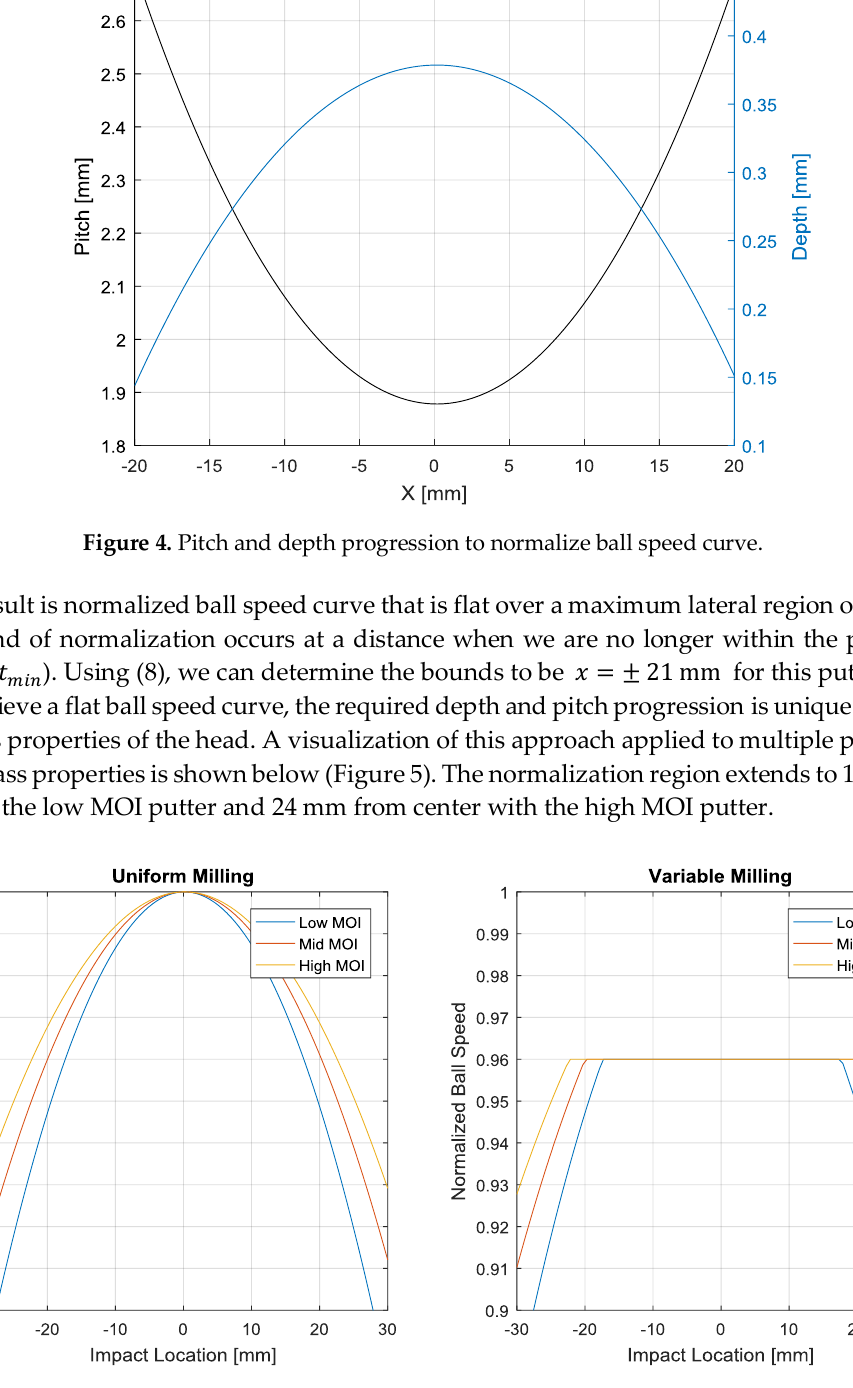
Figure 5. Normalization for putters with different mass/inertia